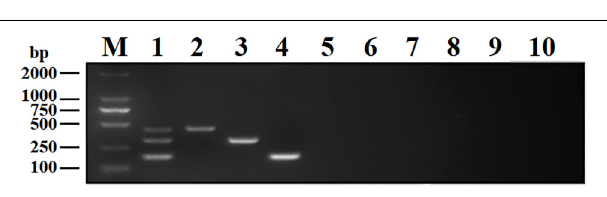
FIGURE 7 | Specificity of the DPO-nanoPCR assay for detecting BRV, BPV, and BVDV. Lane M, DL2000 DNA marker; Lane 1, BRV, BPV, and BVDV; Lane 2, BRV; Lane 3, BPV; Lane 4, BVDV; Lane 5, BRSV; Lane 6, PoRV; Lane 7, PPV; Lane 8, PEDV; Lane 9, TGEV; Lane 10, negative